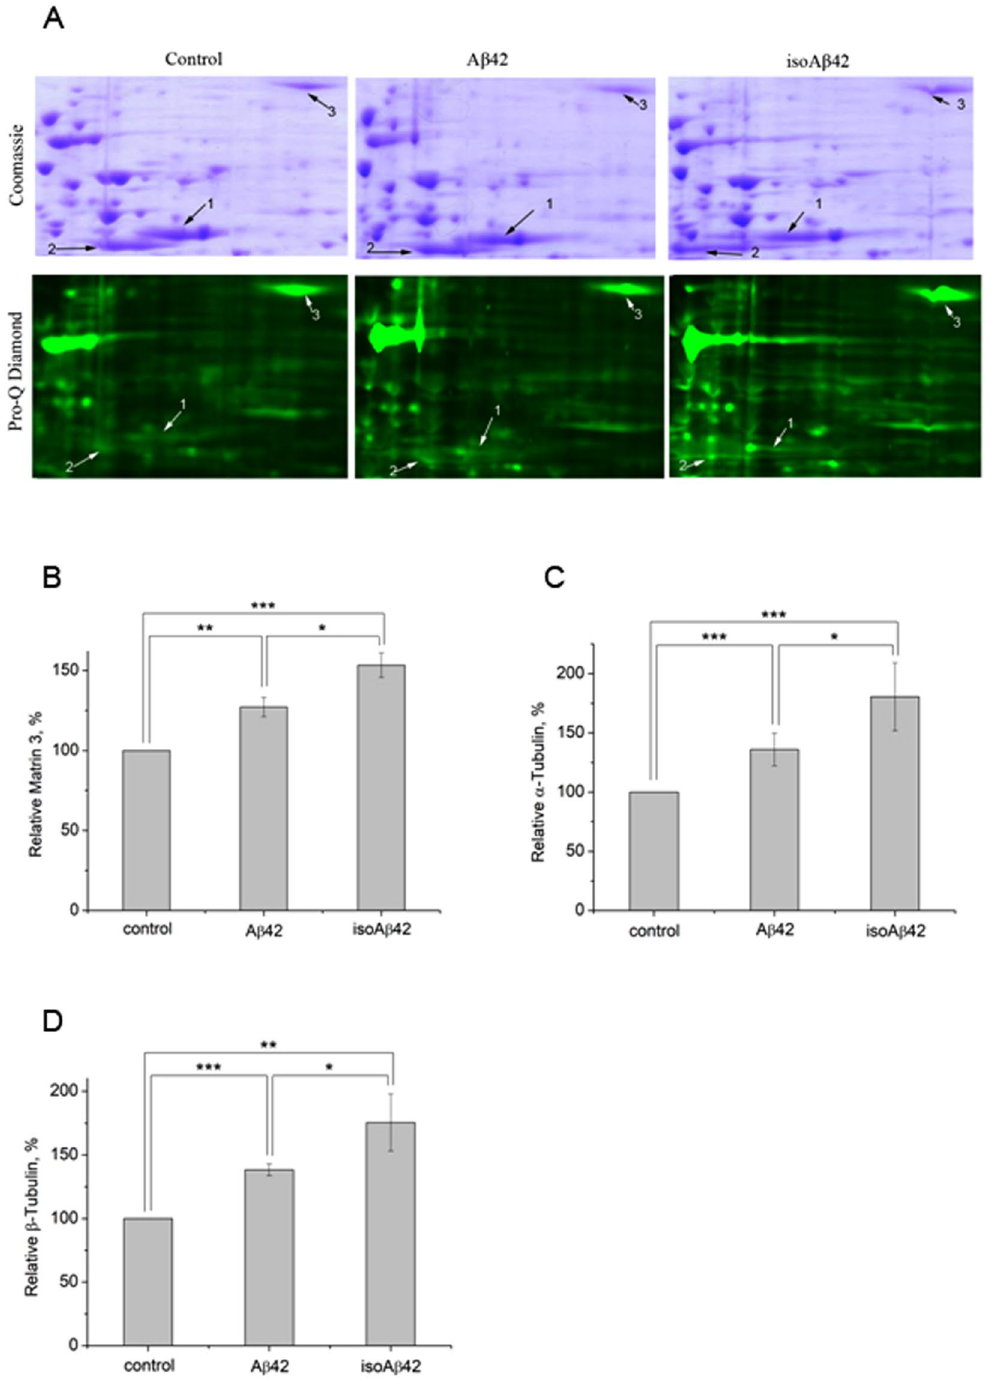
Figure 6. Visualization of the changes in protein phosphorylation levels after SH-SY5Y cells incubation with A β 42 or isoA β 42 (10 μ M, 6 h). Extracted proteins were separated by 2D electrophoresis. In the second dimension, proteins were separated on 11% SDS-PAGE, followed by Pro-Q diamond phosphoprotein staining and after image acquisition were restained with Comassie R -250 ( A ). 1 – α -tubulin, 2 - β -tubulin, 3- matrin 3. Densitometric analysis was performed using Fiji ImageJ software. Phosphorylated matrin 3 ( B ), α -tubulin ( C ) and β -tubulin ( D ) stained with Pro-Q diamond phosphoprotein stain were normalized to its total amount stained with Coomassie R-250. Each value is the mean expressed as a percentage of the protein phosphorylation level in the control group ± SD of at least three independent experiments; * p < 0.05, ** p < 0.005, *** p <